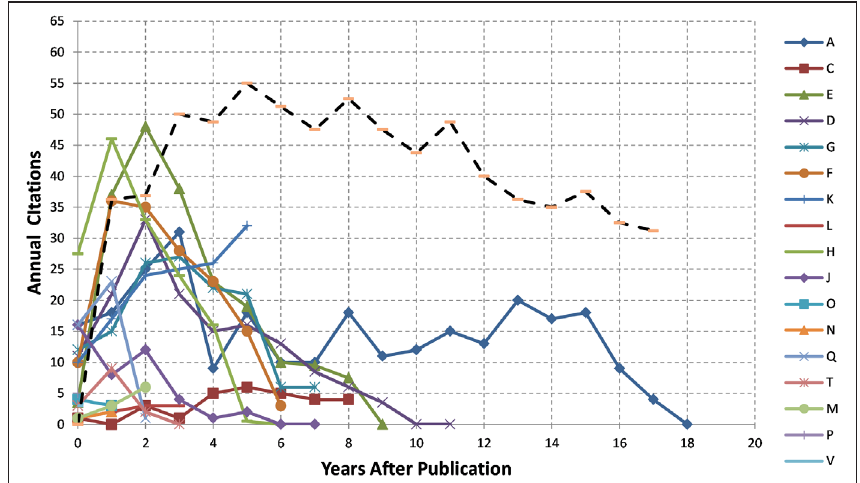
Figure 1: Citation histories for each project shifted to the start of the first citation year. The legend gives the symbol identifications in terms of the A-W project entries in Table 3. For plotting purposes, the history values for the three largest projects (D: Galaxy Zoo , E: Einstein@Home , and H: Planet Hunters ) have been reduced by a factor of 2, 2, and 20 respectively, to focus attention on their profile shapes. The dashed line is the aggregate citation history by Abt (1981) for the 326 papers published in 1961 but reduced by a factor of